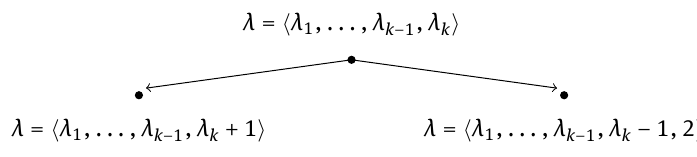
Figure 17: Splitting rule that defines the binary tree in Figure